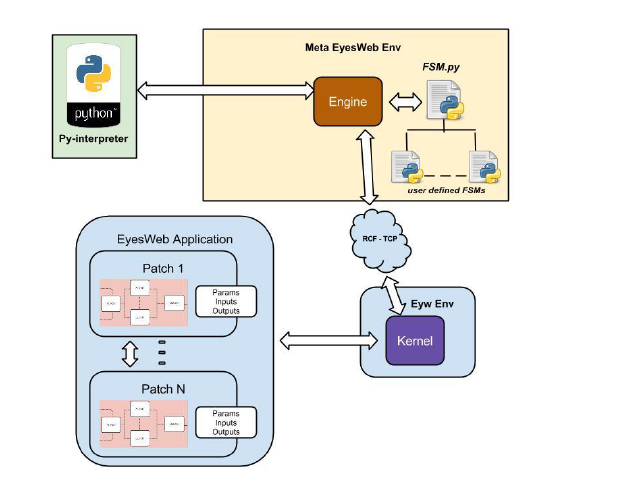
Figure 3. The system architecture for the STARC project